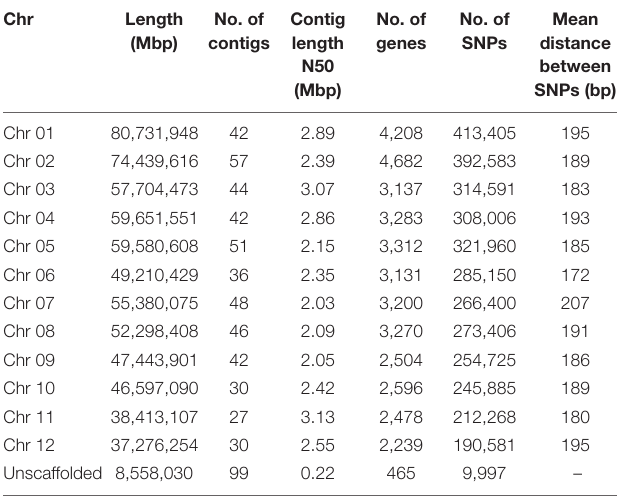
TABLE 3 | Annotation statistics and completeness assessment of the ‘KA01’ reference genome. Annotation